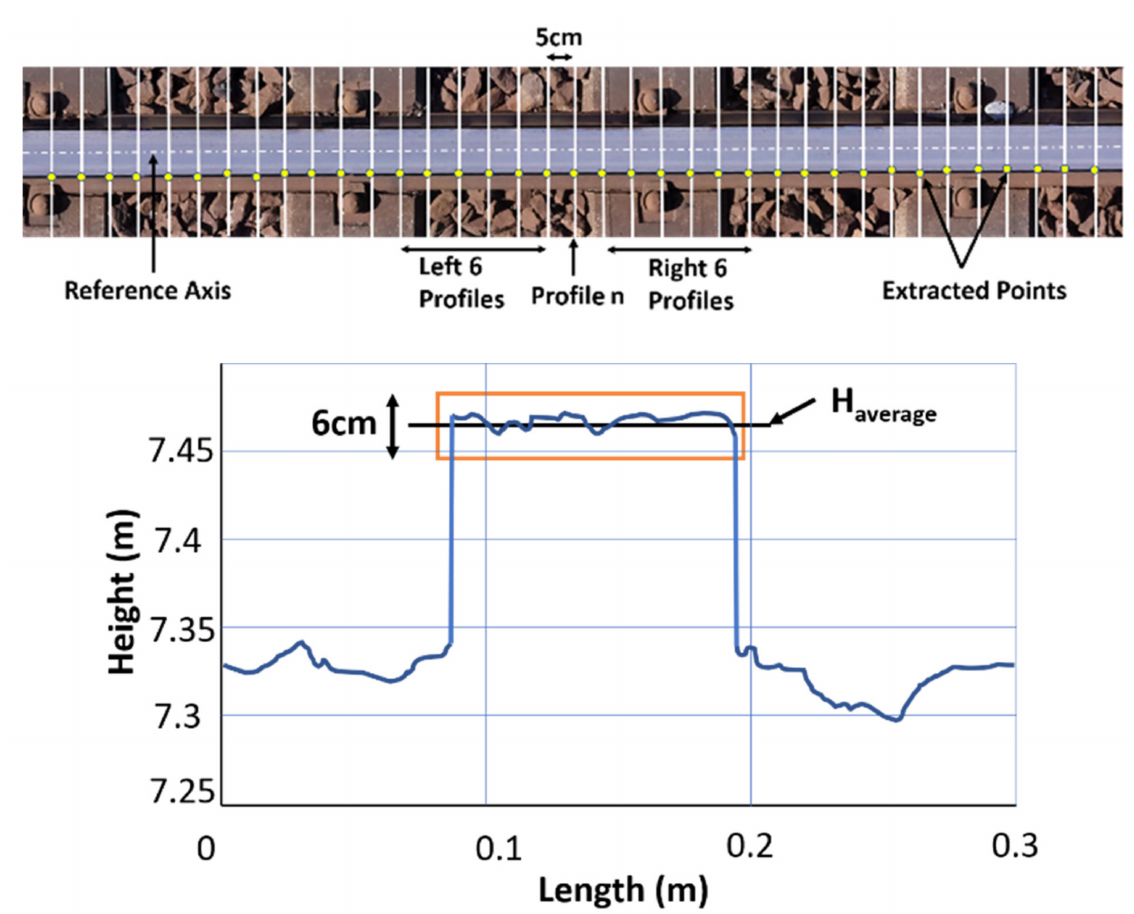
Figure 8. Upper: simulated cuts at 5 cm each, averaging over 6 profiles, reference axis; lower: profile